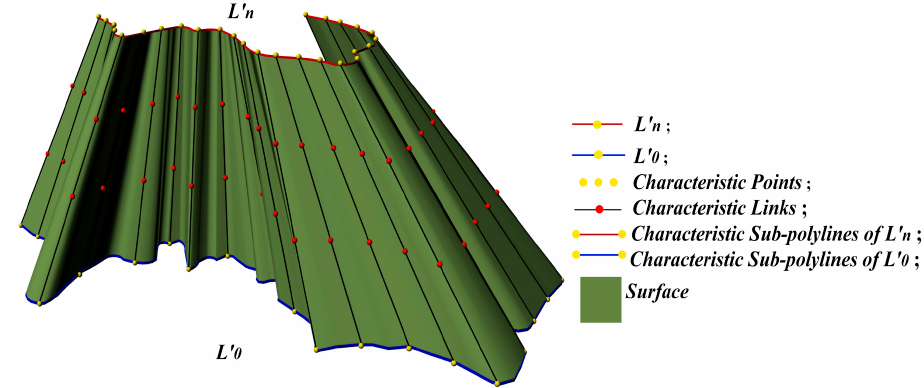
Figure 4. Established CCS.